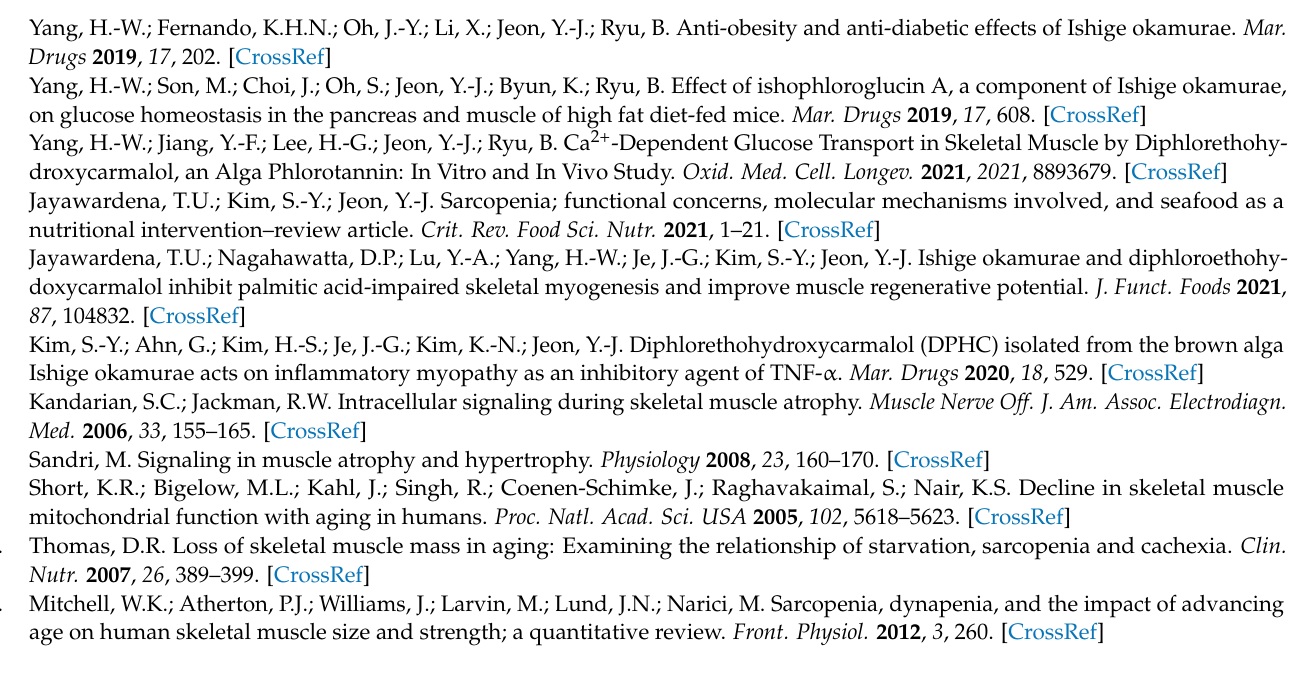
(B) chromogram data of DPHC in IO and standard curve data for quantification of DPHC (C). Figure S2: Levels of mRNA related to oxidative stress in gastrocnemius muscle of DEX-treated mice displaying muscle atrophy; Figure S3: Levels of mRNA related to oxidative stress in soleus muscle of DEX-treated mice displaying muscle atrophy; Table S1: List of primer for